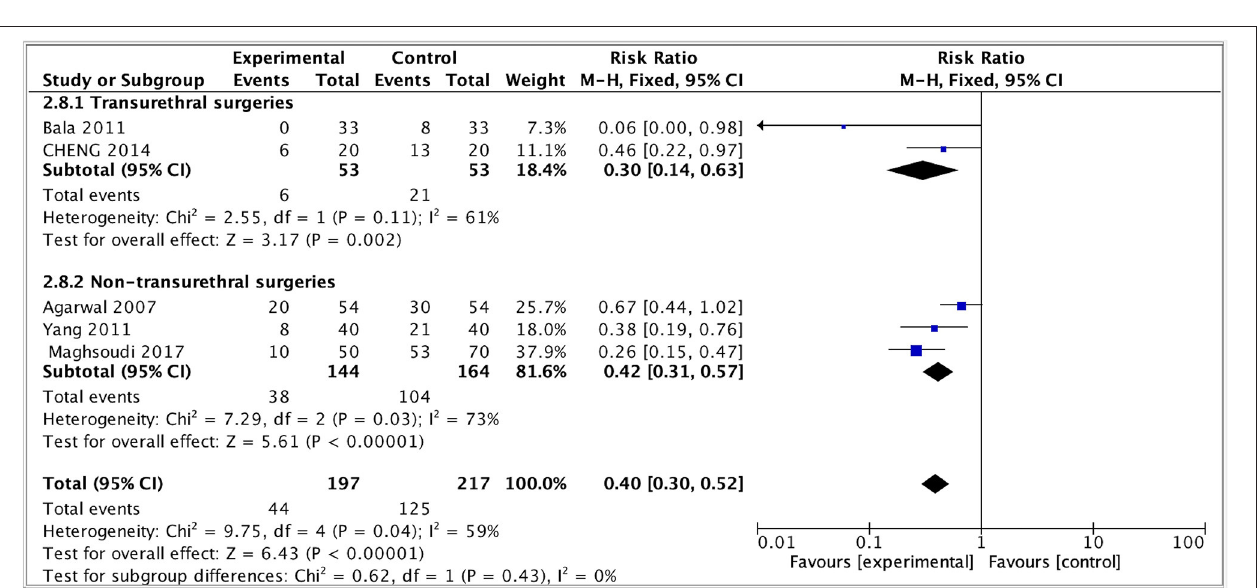
FIGURE 7 | Subgroup